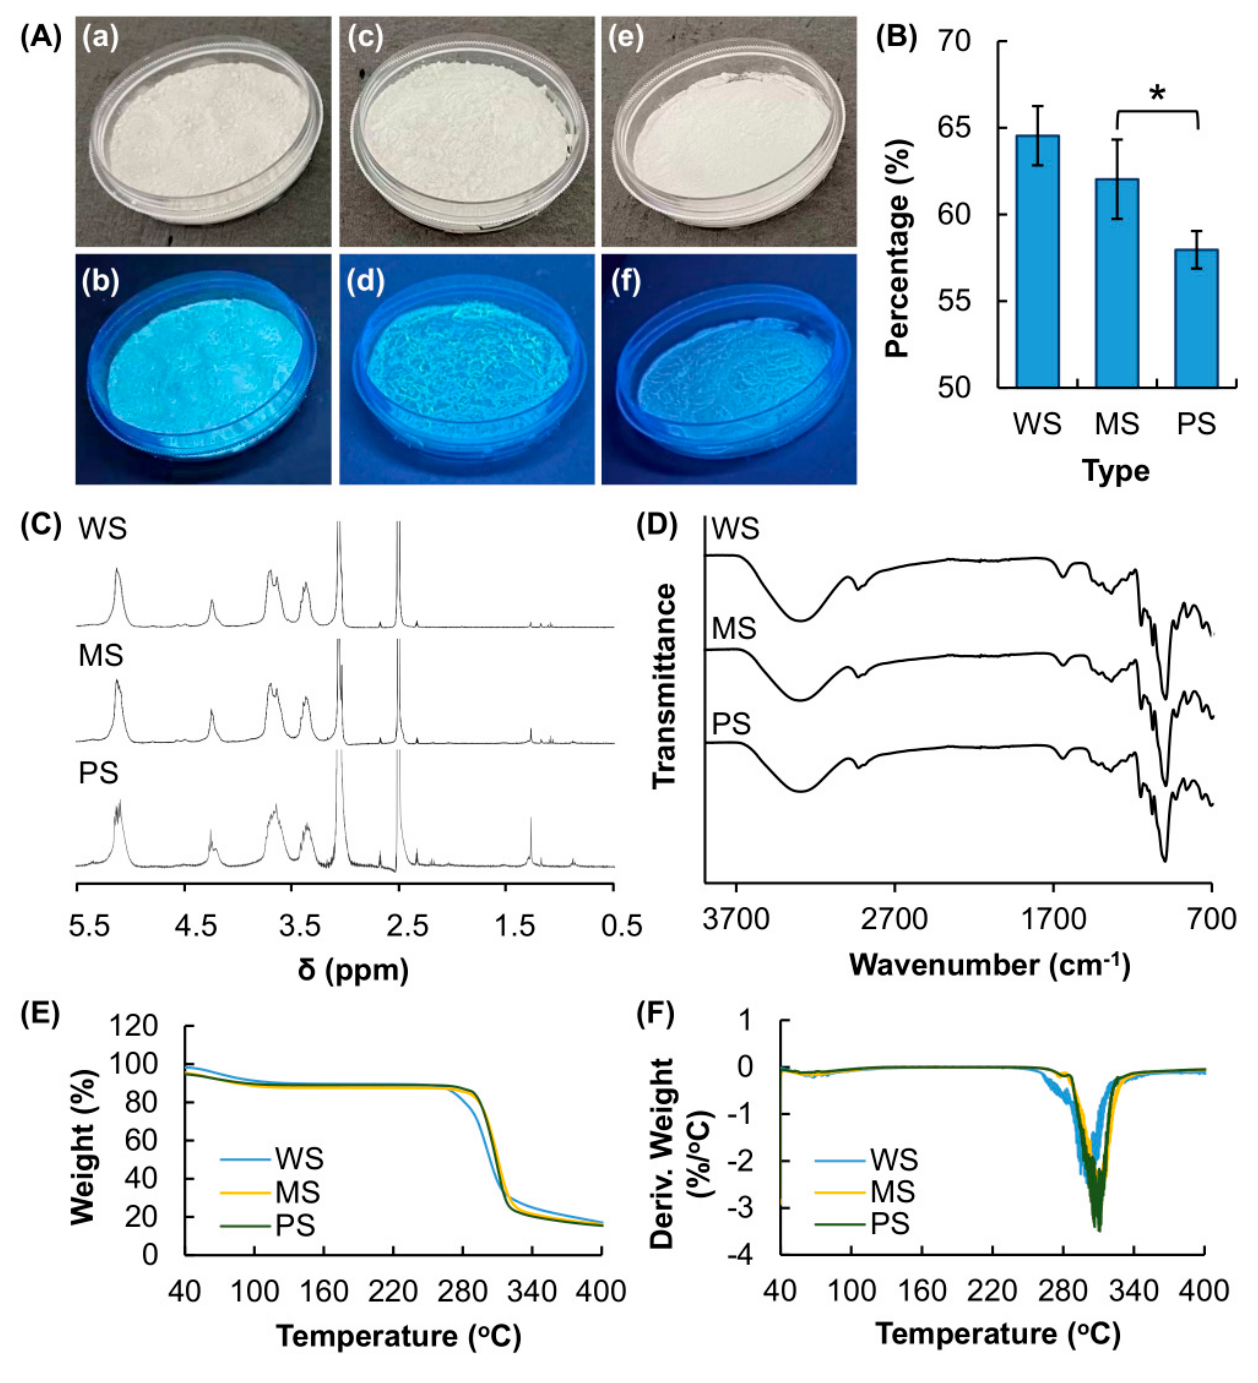
Figure 1. ( A ) Images of ( a , b ) water chestnut starch (WS), ( c , d ) maize starch (MS) and ( e , f ) potato starch (PS) under ( a , c , e ) white light and ( b , d , f ) UV light. The wavelength of UV light is at 365 nm. ( B ) Amylose content of starch obtained from different botanical sources. * p < 0.05. ( C ) 1 H-NMR spectra (400 MHz) of WS, MS and PS. The solvent used is DMSO-d6, and the spectra are recorded at 80 ◦ C. ( D ) Fourier-transform infrared (FTIR) spectra, ( E ) thermogravimetric analysis (TGA) curves and ( F ) derivative thermogravimetry (DTG) curves of WS, MS and PS. Despite variations in the amylose content, the NMR spectra of WS, MS and PS show the same pattern (Figure 1C), with chemical shifts assigned to the methylidyne and